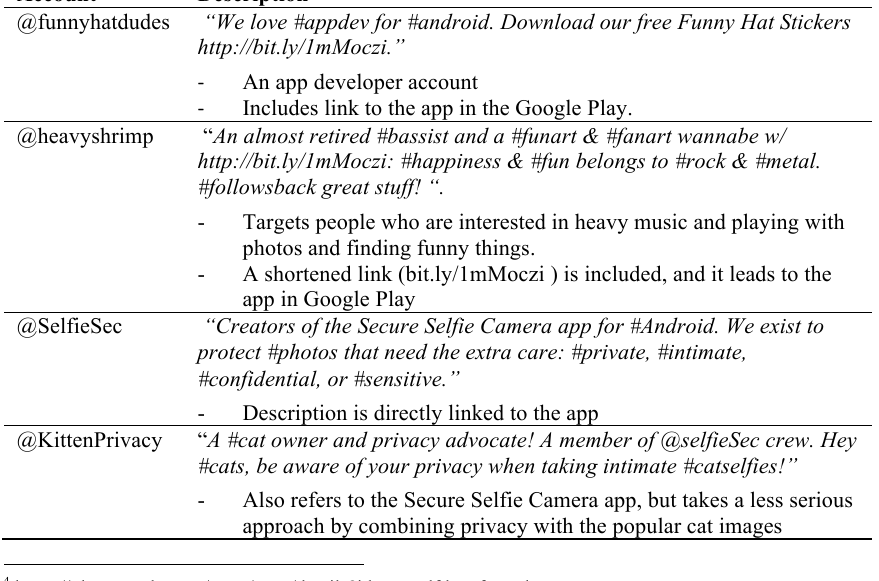
Table 1 . Description of the analysed